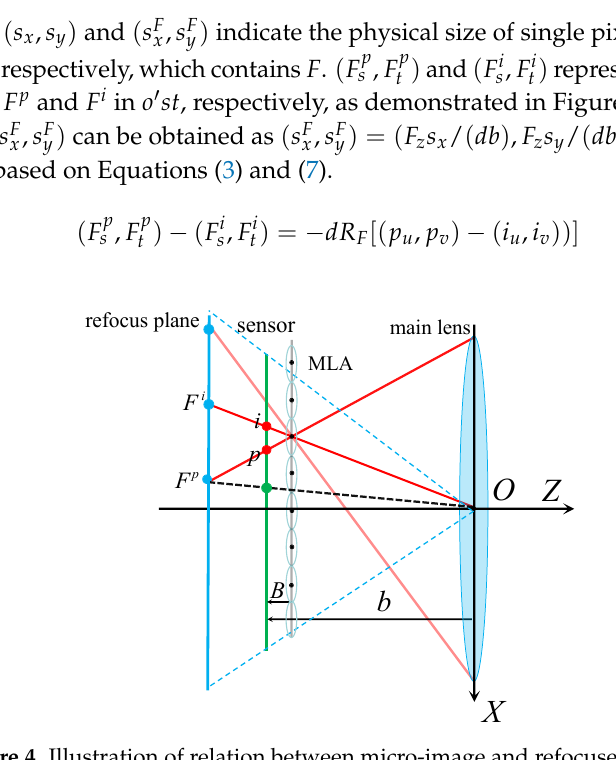
Figure 4. Illustration of relation between micro-image and refocused